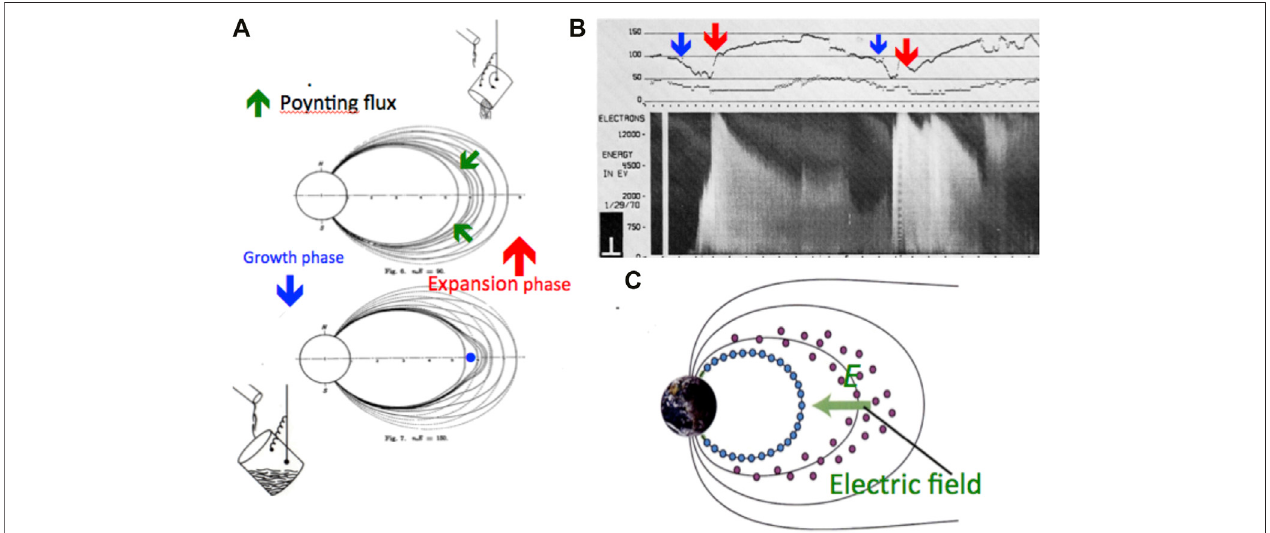
FIGURE 19 | (A) The in fl ation-de fl ation sequence. (B) The in fl ation (blue arrow)-de fl ation (red arrow) sequence is observed as a sequence of decrease-increase of the magnetic fi eld intensity at 6 Re (DeForest and McIlwain, 1971), together with a sudden increase of the electron fl ux at the time of de fl ation. (C) During the de fl ation, electronsare closely tiedto inward moving magnetic fi eld lines, while protons arenot. Thus,a charge separation isexpected to occur during the de fl ation,generating an earthward electric fi eld, which can drive Bostrom ’ s current system during the expansion